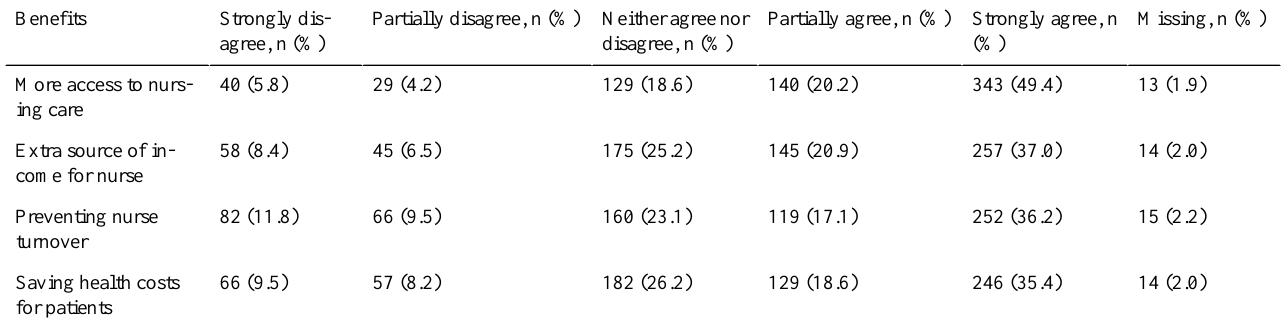
Table 3. Perceived benefits toward sharing nurse program in China of participants (n=694).